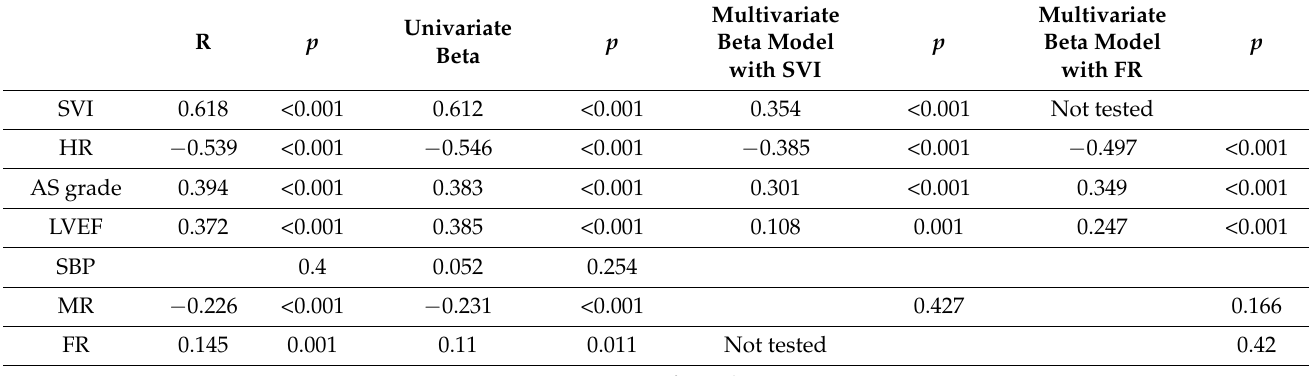
Table 2. Determinants of LVET in overall patients: correlations and linear regression analysis.